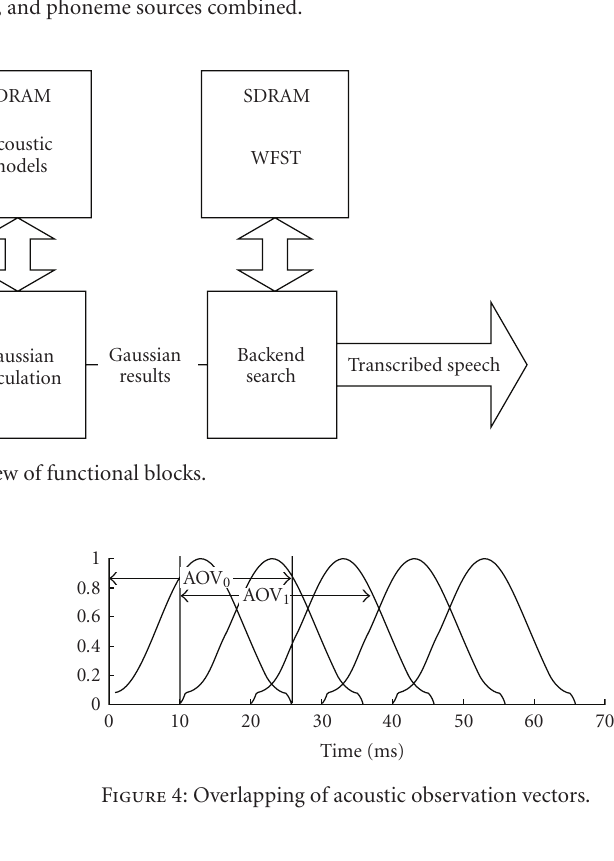
Figure 1: Language, lexicon, and phoneme sources combined.